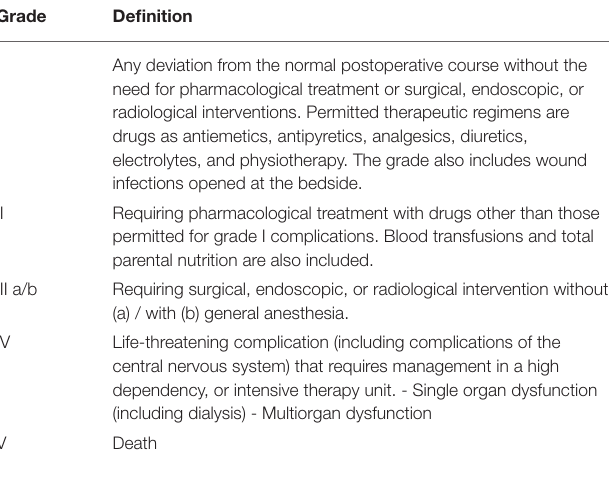
TABLE A1 | Clavien-Dindo classification of surgical complications